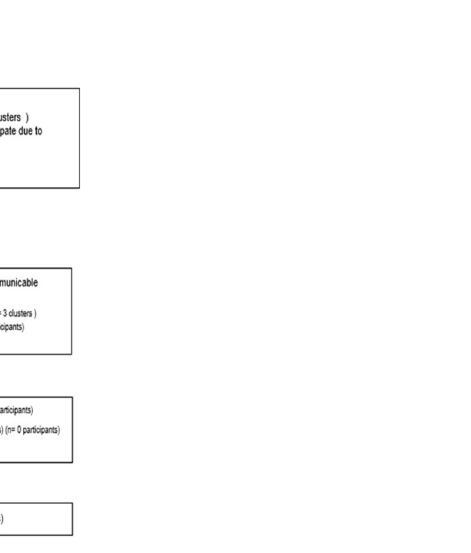
Fig 1. Flow chart diagram of the study using CONSORT